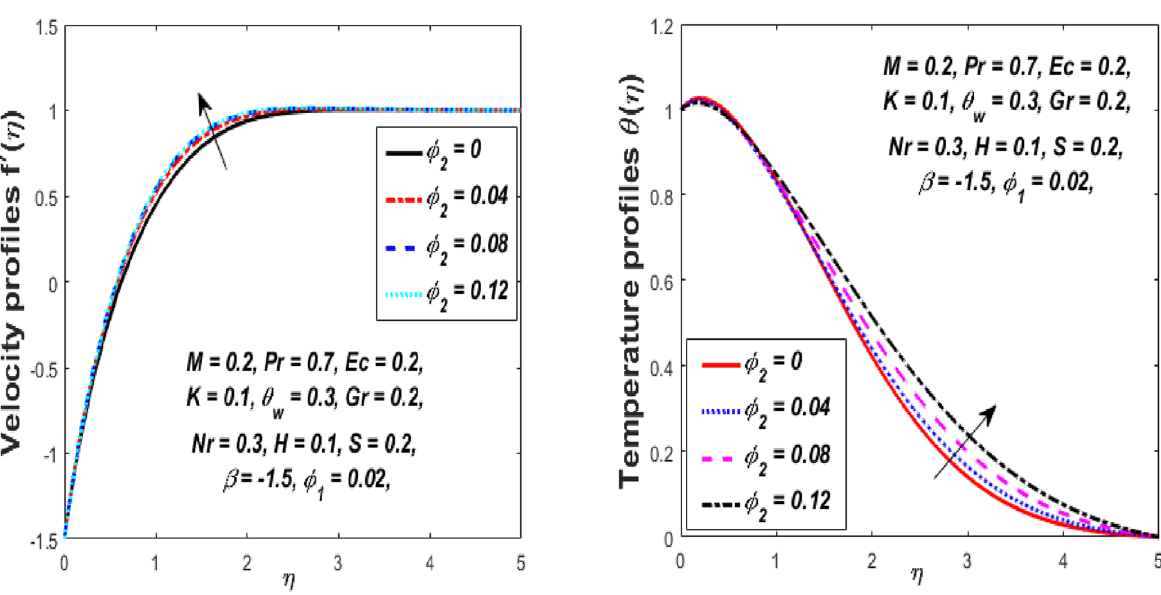
Figure 12. Influence of φ 2 on velocity f ′ (η) and temperature θ(η)